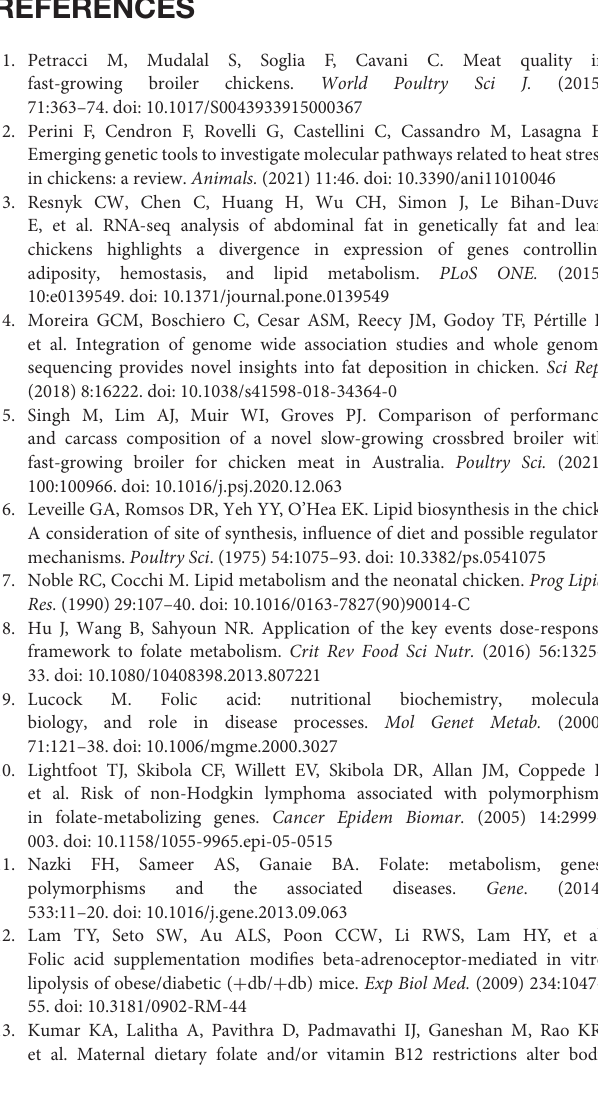
Supplementary Table 2 | Primers used for qPCR. Supplementary Table 3 | Sample sequencing data assessment statistics. Supplementary Table 4 | New genes were successfully annotated. Supplementary Table 5 | Top 5 up and down regulated DEGs according to log 2 FC value among groups. Supplementary Table 6 | Significantly enriched pathways of DEGs among